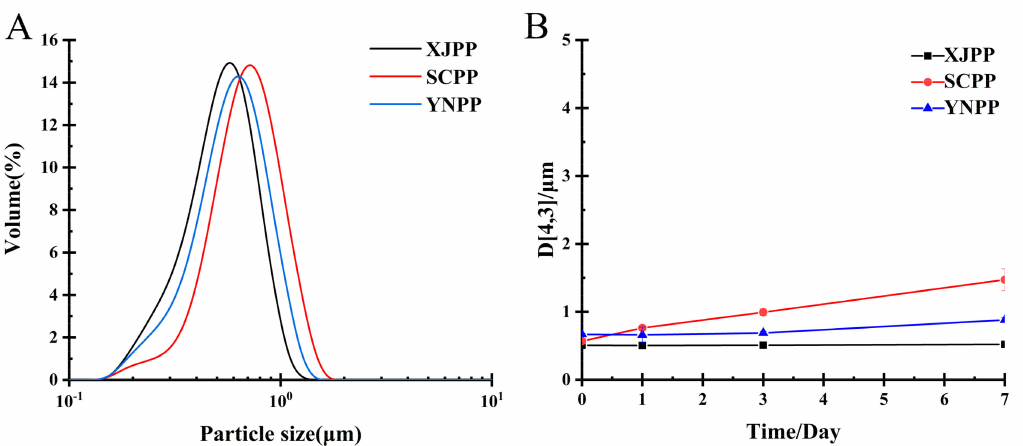
Figure 2. Particle size distribution of 1.5% pomegranate peel pectin emulsion ( A ), droplet size change during seven days of storage under 60 ◦ C ( B ) (The results in Figure 2B were from samples prepared at a later time.).